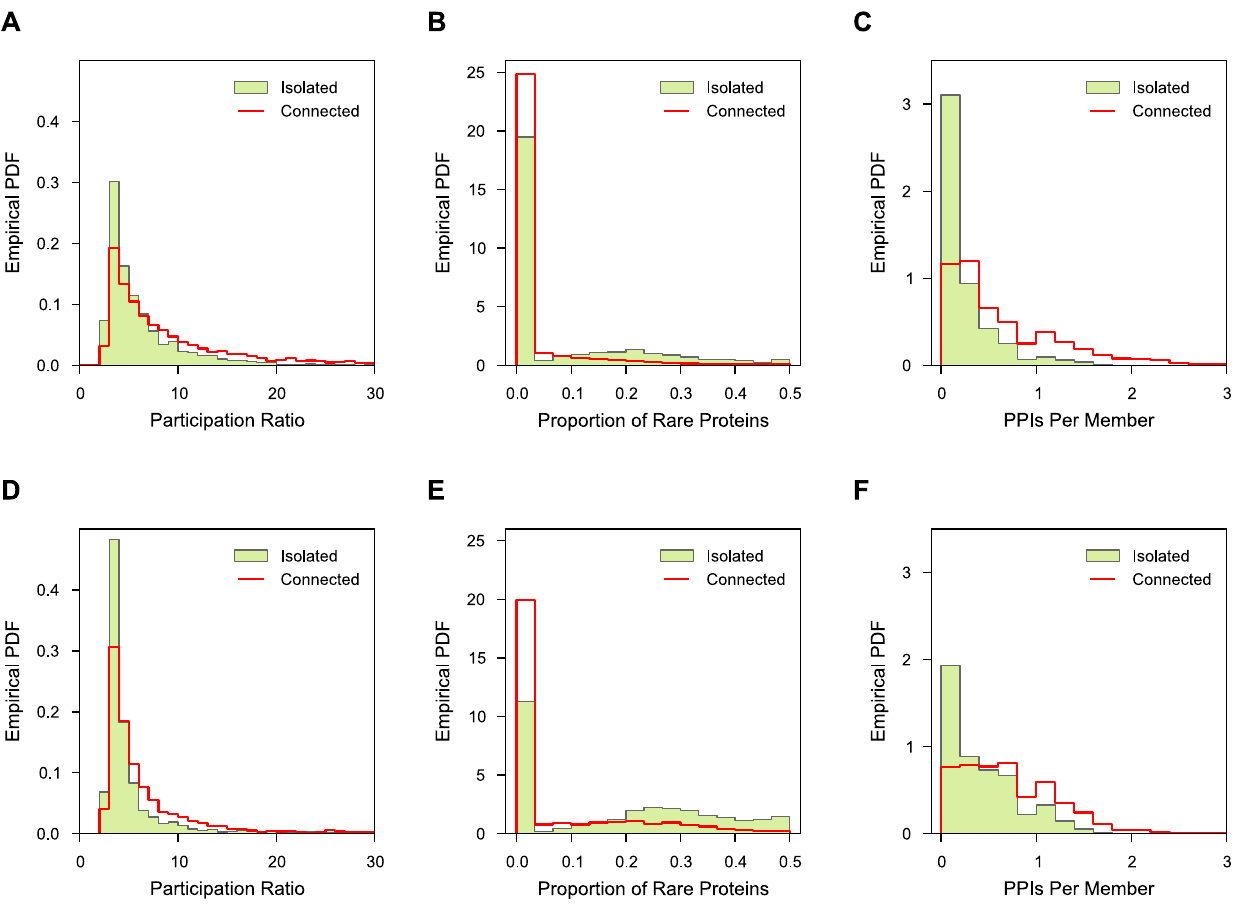
Figure 5. Comparison of empirical distributions of selected features of isolated and connected nodes. Each plot shows two histograms of empirical probability density functions for a node feature, one for isolated and one for connected nodes. Top row ( A , B , C ) shows features in yeast, bottom ( D , E , F ) in human. Features: participation ratio (effective complex size derived from protein weights – A , D ), proportion of proteins occurring in not more than 4 complexes ( B , E ), and number of direct interactions per protein member ( C , F ).